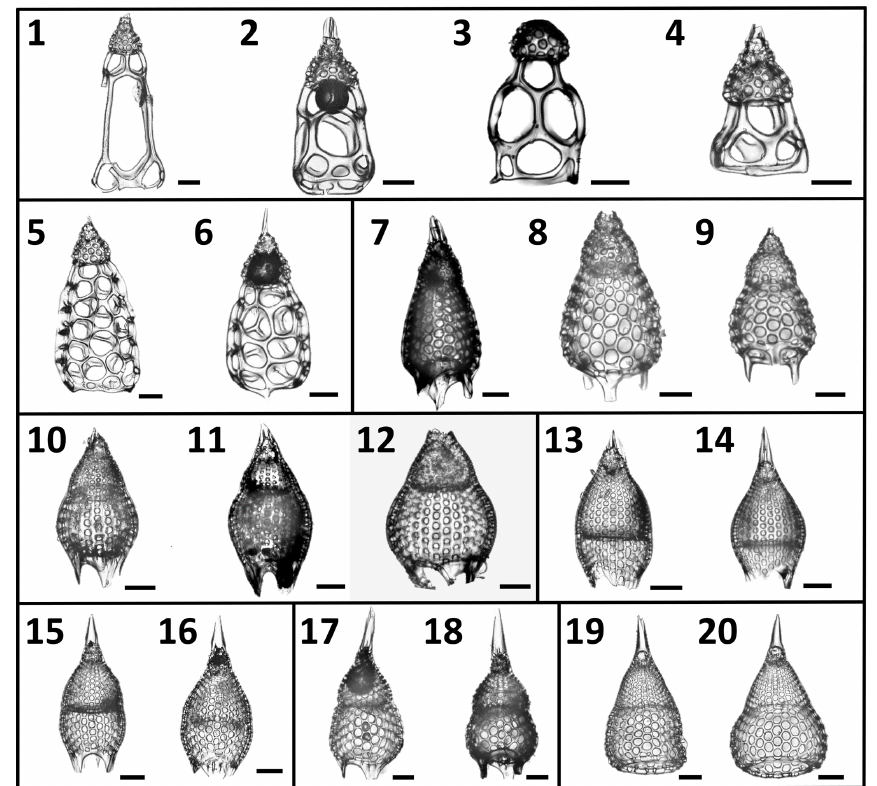
Figure 2. A selection of the variety of Podocyrtis morphotypes analyzed in this study. (1–4) P. goetheana . (1–2) from 207_